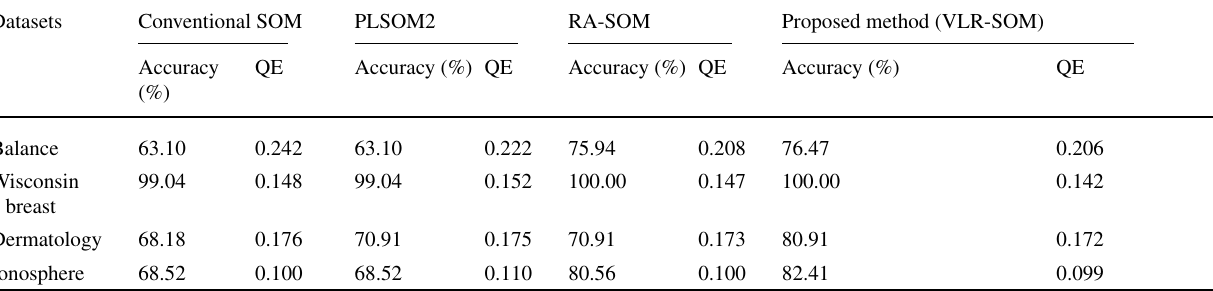
Table 11 Comparative analysis of conventional SOM, PLSOM2, and proposed RZA-SOM algorithms on four UCI benchmark datasets